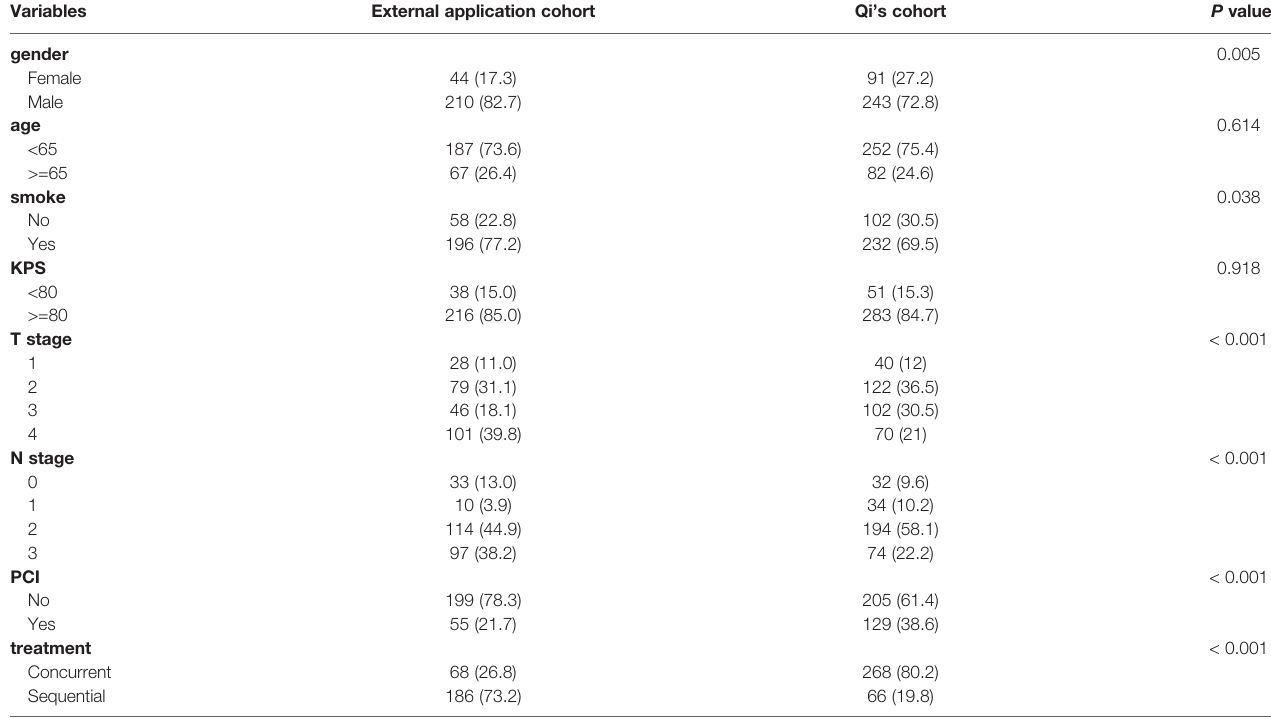
TABLE 1 | Baseline characteristics of the external application and Qi ’ s